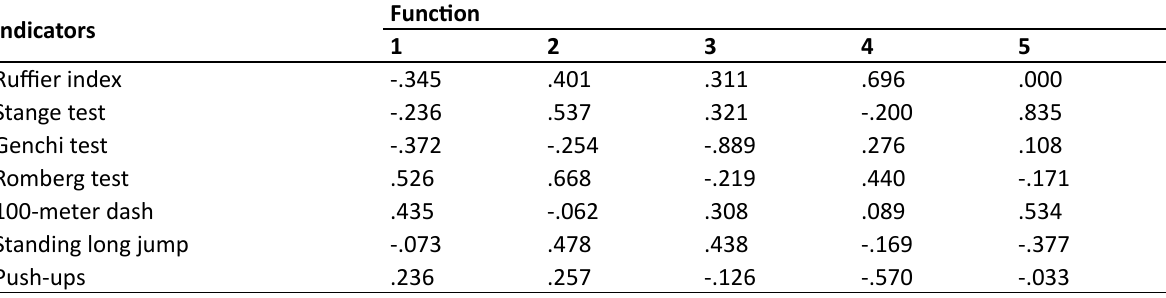
Table 6. Structure Matrix